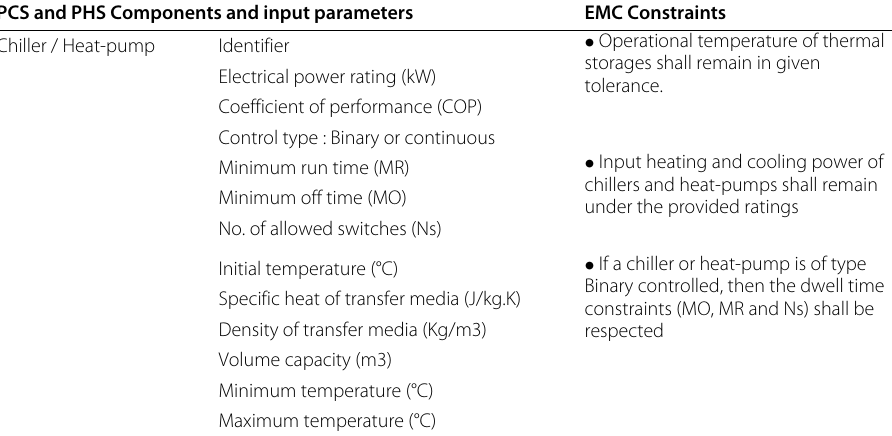
Table 3 Description of PCS and PHS and constraints in the model library PCS and PHS Components and input